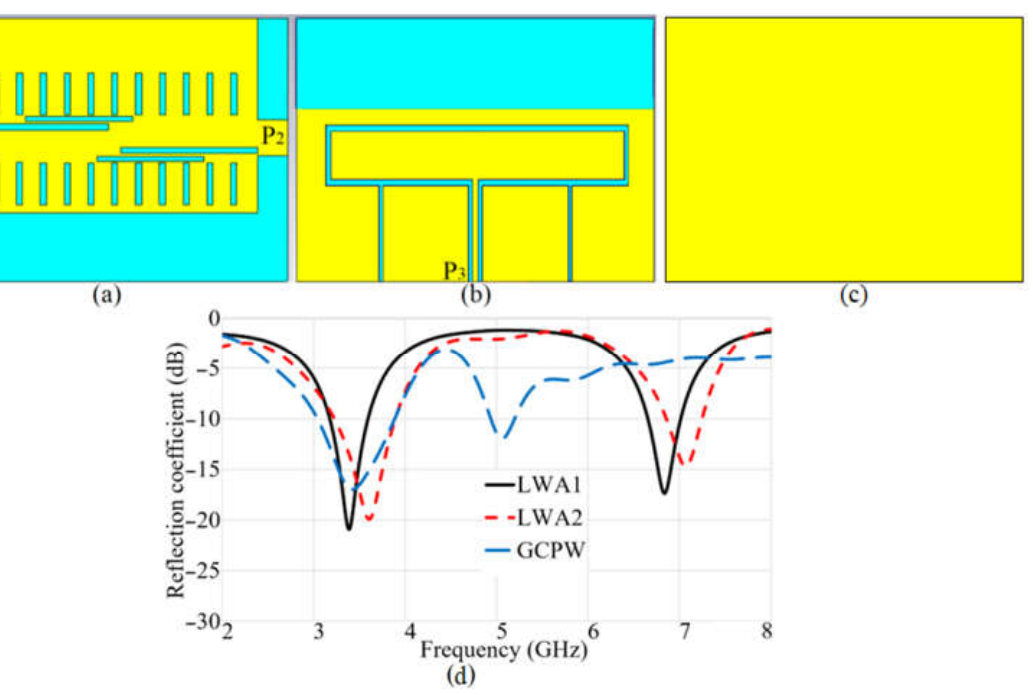
Figure 6. Each part of the MIMO antenna and its reflection coefficient results in ( a ) LWA 1 (P1) and LWA 2 (P2), ( b ) GCPW feed antenna, ( c ) ground view of the antenna, and ( d ) reflection coefficient results of each part of the MIMO.